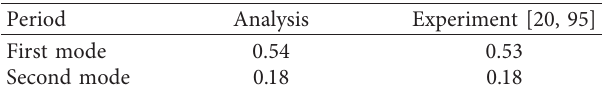
Table 4: The first and second analytical periods ( s ) obtained from analysis and experiment.